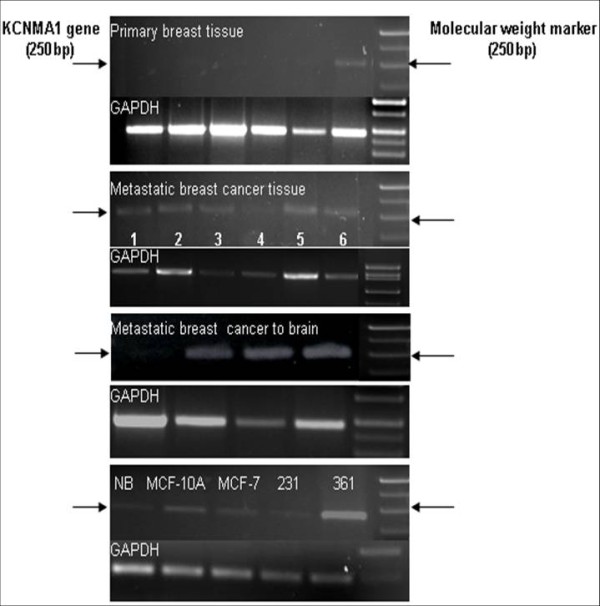
Analysis of KCNMA1 gene expression by RT-PCR. Semiquantitative RT-PCR analyses of human primary breast cancer (n = 6), metastatic breast cancer {n = 6, sample 1 (metastasized to ovary), 2 and 3 (metastasized to liver), 4–6 (metastasized to lymph node)}, metastasized to brain (n = 4) and breast cancer cell lines reveals differential expression of KCNMA1 gene expression (α-subunit, 250 bp). GAPDH was used as the loading control. NB: Normal breast tissue, MCF-10A (normal breast cell line), MCF-7 (non mets), 231: MDA-MB-231 (Mets) and 361: MDA-MB-361 (Brain Mets). Note: Only one of six primary breast cancer tissues showed detectable amount of KCNMA1 RNA (see arrow).